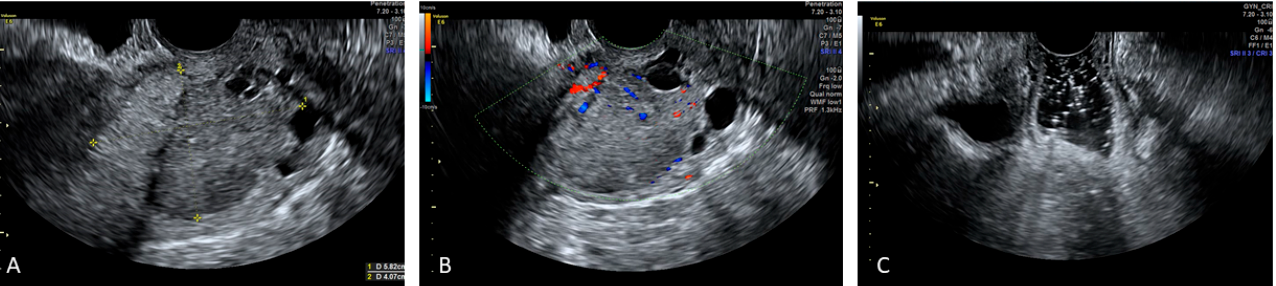
Figure 4. Reports the SVG image of a mixed echogenicity cervical cancer lesion whose caudal limit is delimited by nabothian cysts (Panel ( A )) and its vascularization (Panel ( B )). SVG reveals regular vaginal walls (Panel ( C )).